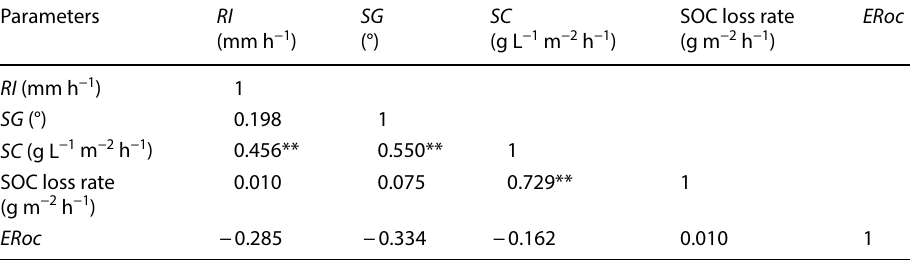
**Correlation is significant at the 0.01 level